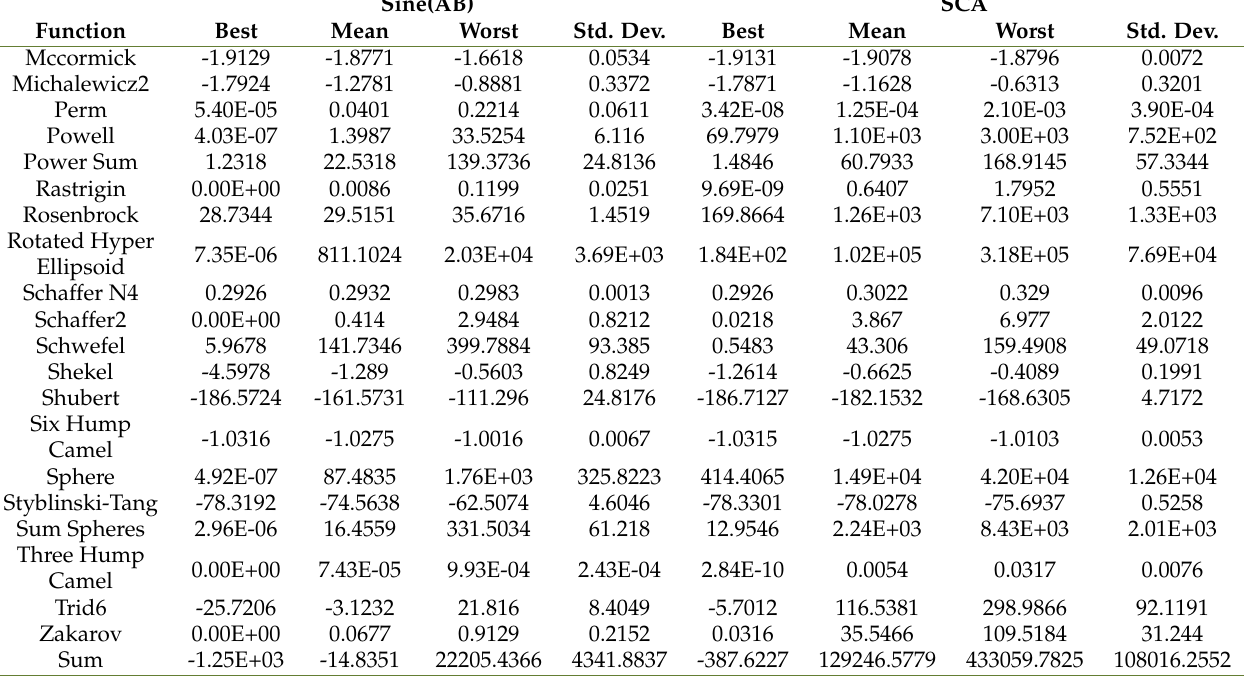
Table 3. Results of a = 1.5 (3 for